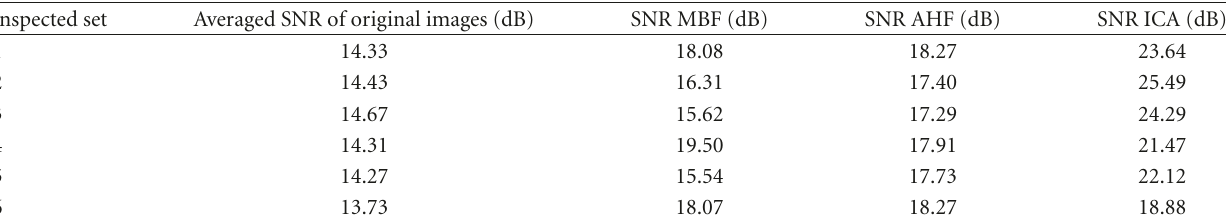
Table 3: Results of enhancing the sets of MO